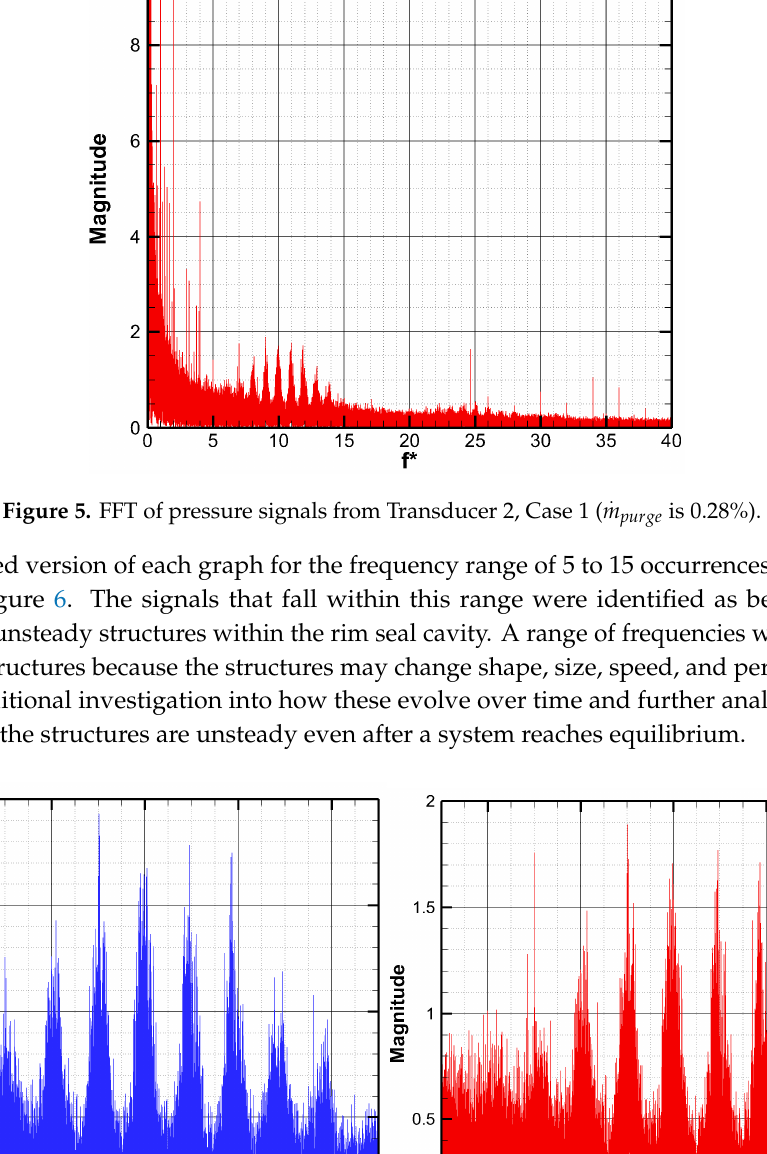
Figure 6. Enhanced view of pressure signals Transducer 1 ( left , blue) and Transducer 2 ( right , red).